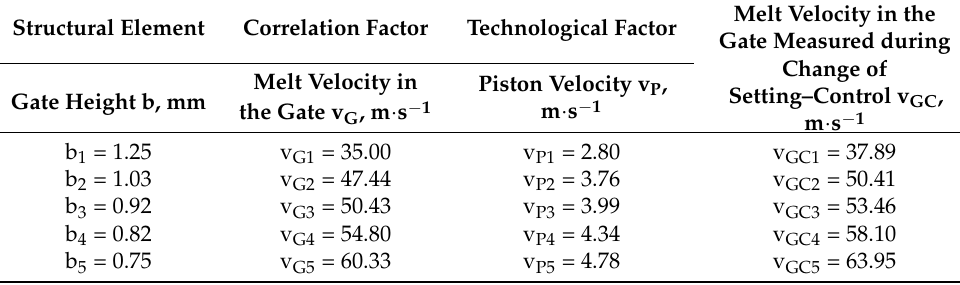
Table 2. Determination of piston velocity with the use of correlation